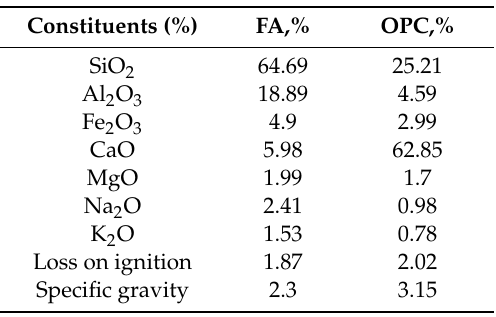
Table 1. Chemical constituent of (OPC) and FA [55,56].